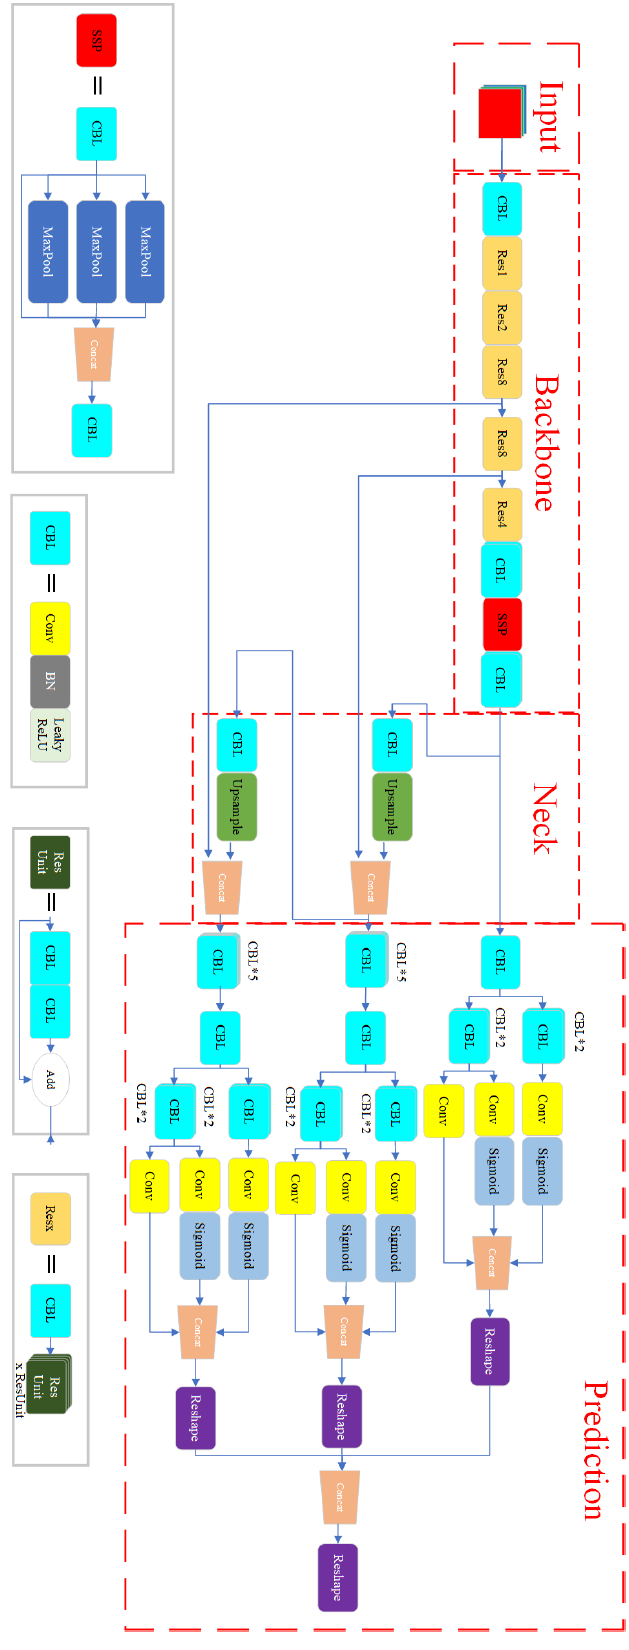
Figure 6. Architecture of YOLOX